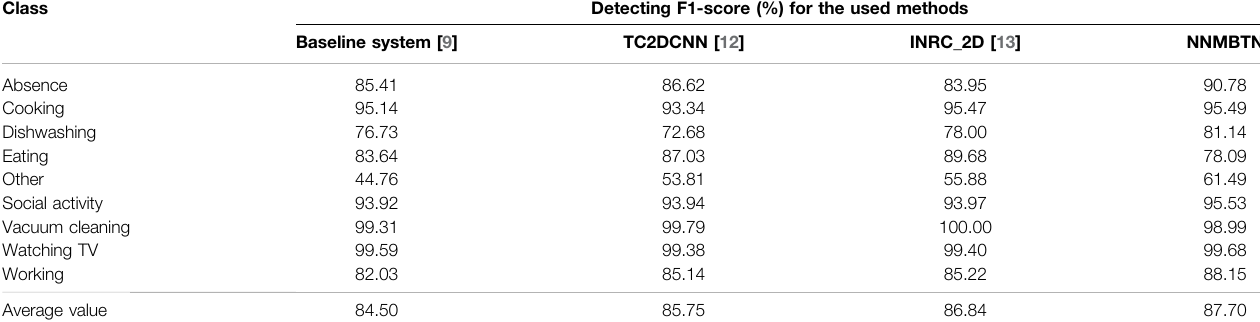
TABLE 2 | Comparison of the neural network model based on the tensor network with other models in the test set of the development dataset. Class Detecting F1-score (%) for the used